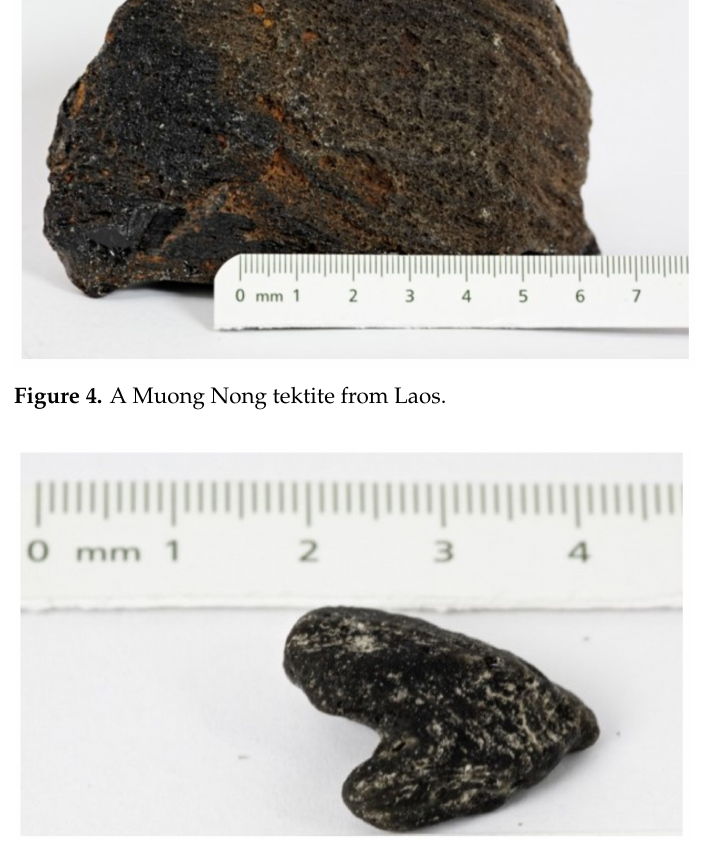
Figure 5. The studied Darwin glass sample from